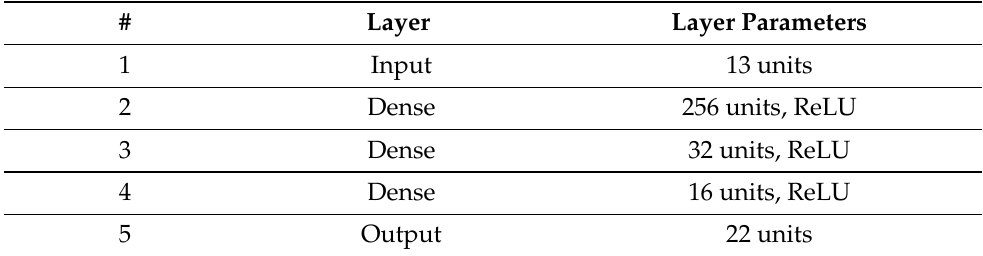
Table 1. FDI LEC